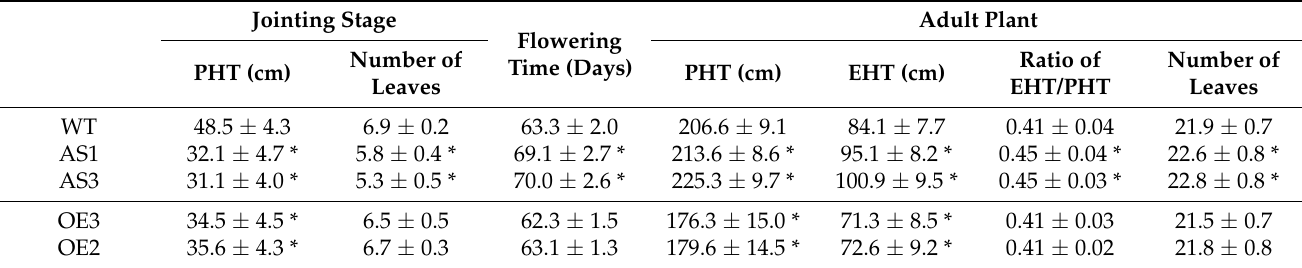
Table 1. The phenotypic variations of the AS and OE